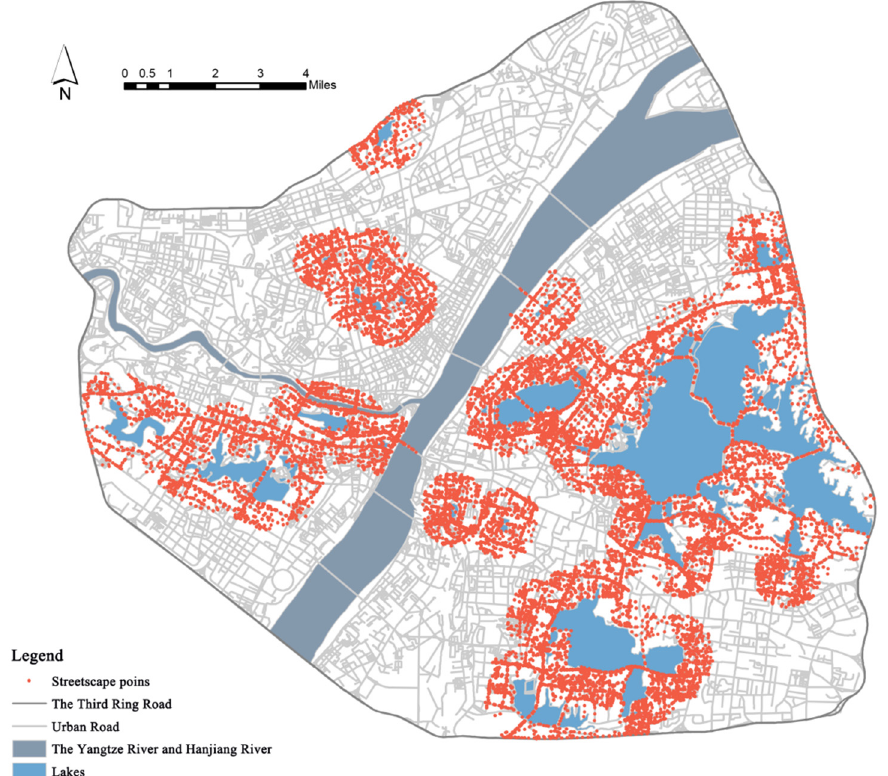
Figure 2. Distribution of streetscape points in the lakefront area.